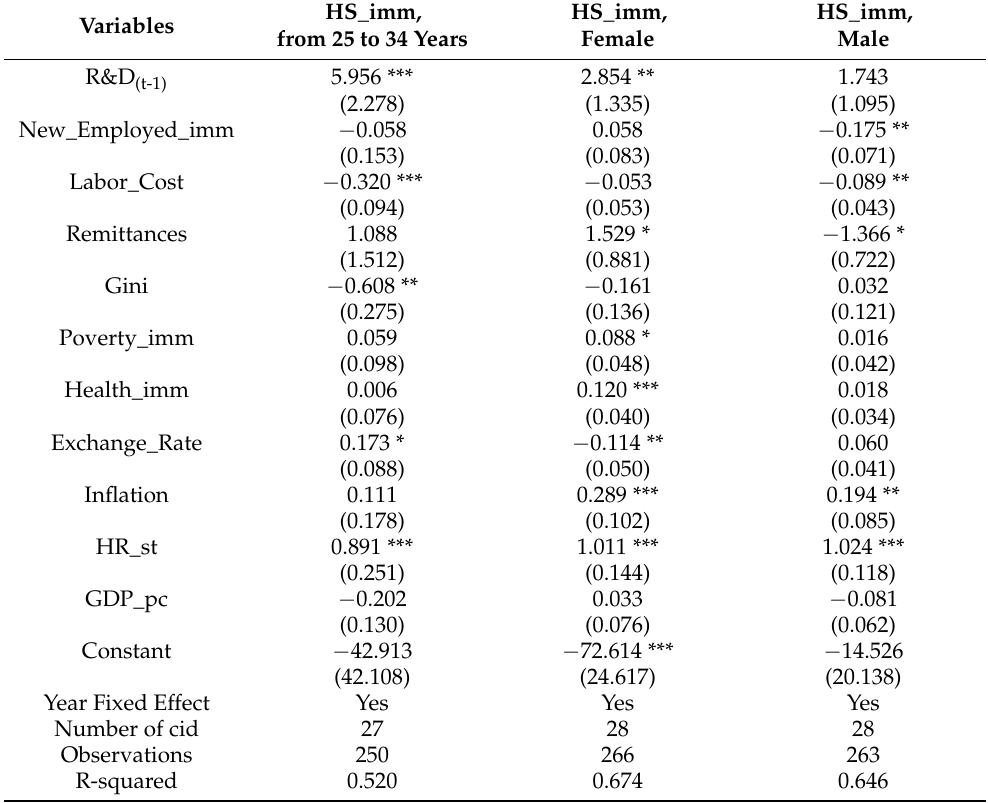
Table 2. Results of the panel specifications, dependent variable is the share of high-skilled immigrants, specific